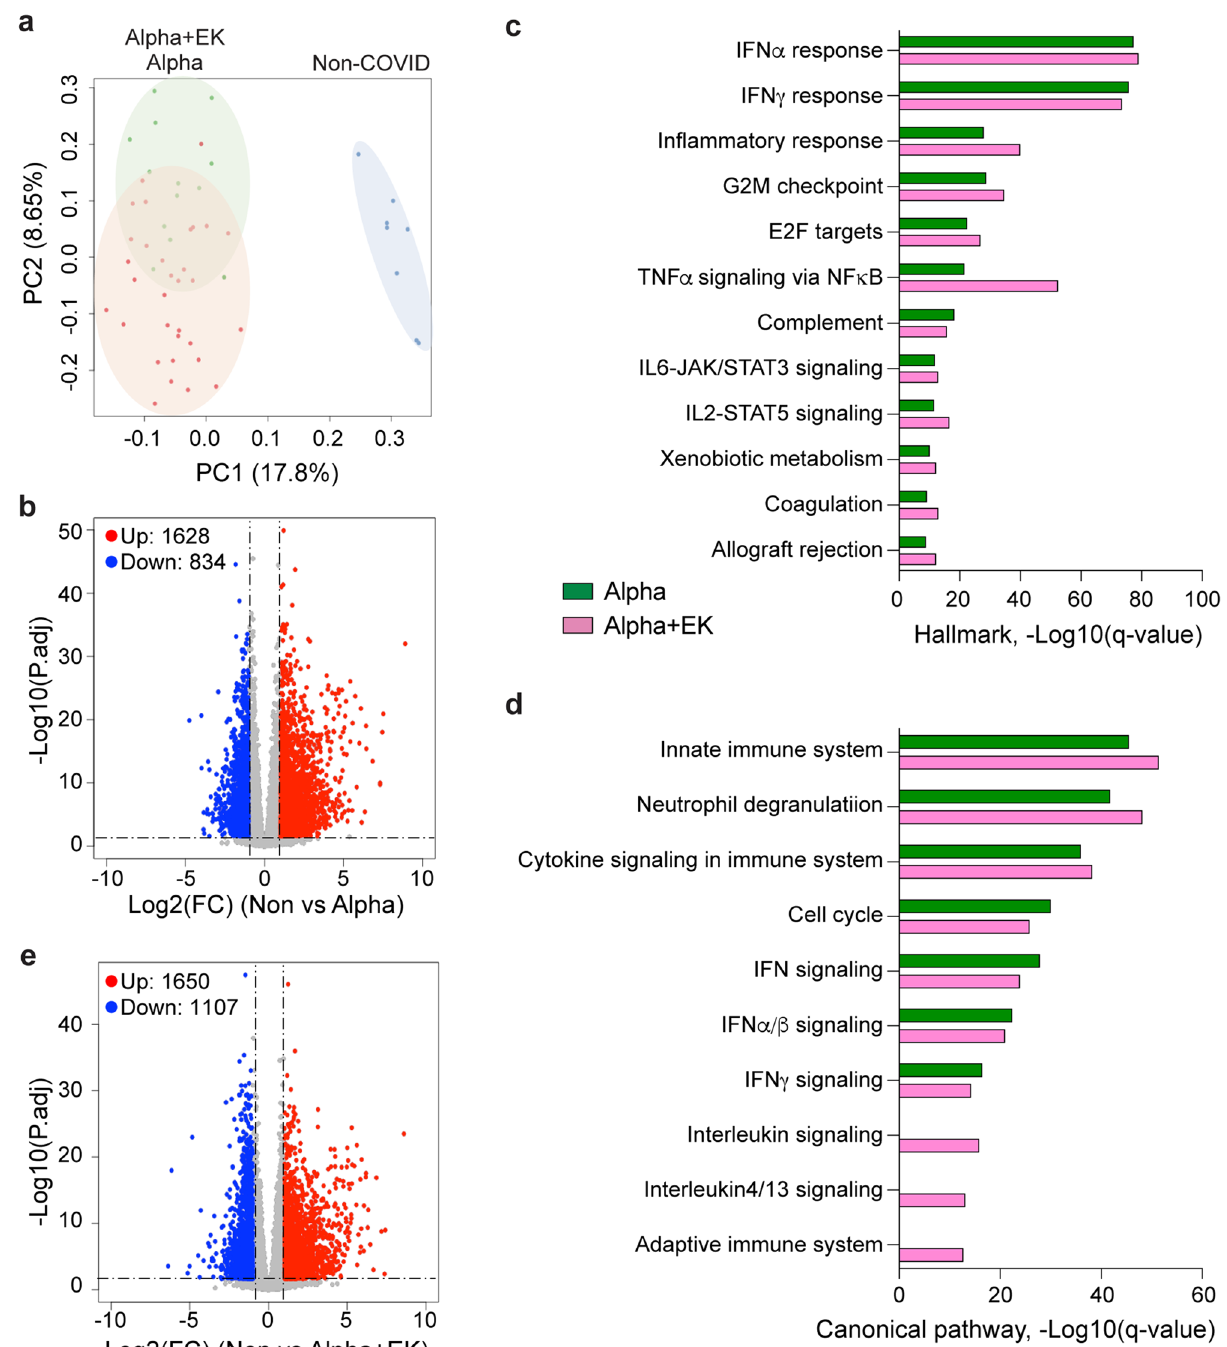
Figure 2. Immune transcriptomes in patients infected with the Alpha or Alpha + EK variants. ( a ) Principal- component analysis (PCA) of transcriptomes of 35 hospitalized patients infected with the Alpha variant (red) and 13 infected with the Alpha + EK variant (green) within 10 days of first symptomology. Eight healthy non-COVID (blue) served as controls. The PCA depicts the variation in the global gene expression profiles across the three cohorts. Principal components 1 (PC1) and 2 (PC2), which represent the greatest variation in gene expression, are shown. ( b ) Volcano plot of DEGs comparing Non-COVID versus Alpha. DEGs (adjusted p -value, p . adj < 0.05) with a log2 fold change (FC) of more than 1 or less than − 1 are indicated in red and blue, respectively. Non-significant DEGs are indicated in gray. The numbers of upregulated and downregulated genes are listed. ( c , d ) Genes expressed at significantly higher levels in the COVID-19 patients were significantly enriched in Hallmark Gene Sets ( c ) and Canonical Pathway Gene sets ( d ). X-axis denotes statistical significance as measured by minus logarithm of FDR q-values. Y-axis ranked the terms by q values (green bars, Alpha; pink, Alpah + EK). ( e ) Volcano plot of DEGs comparing Non-COVID versus Alpha +